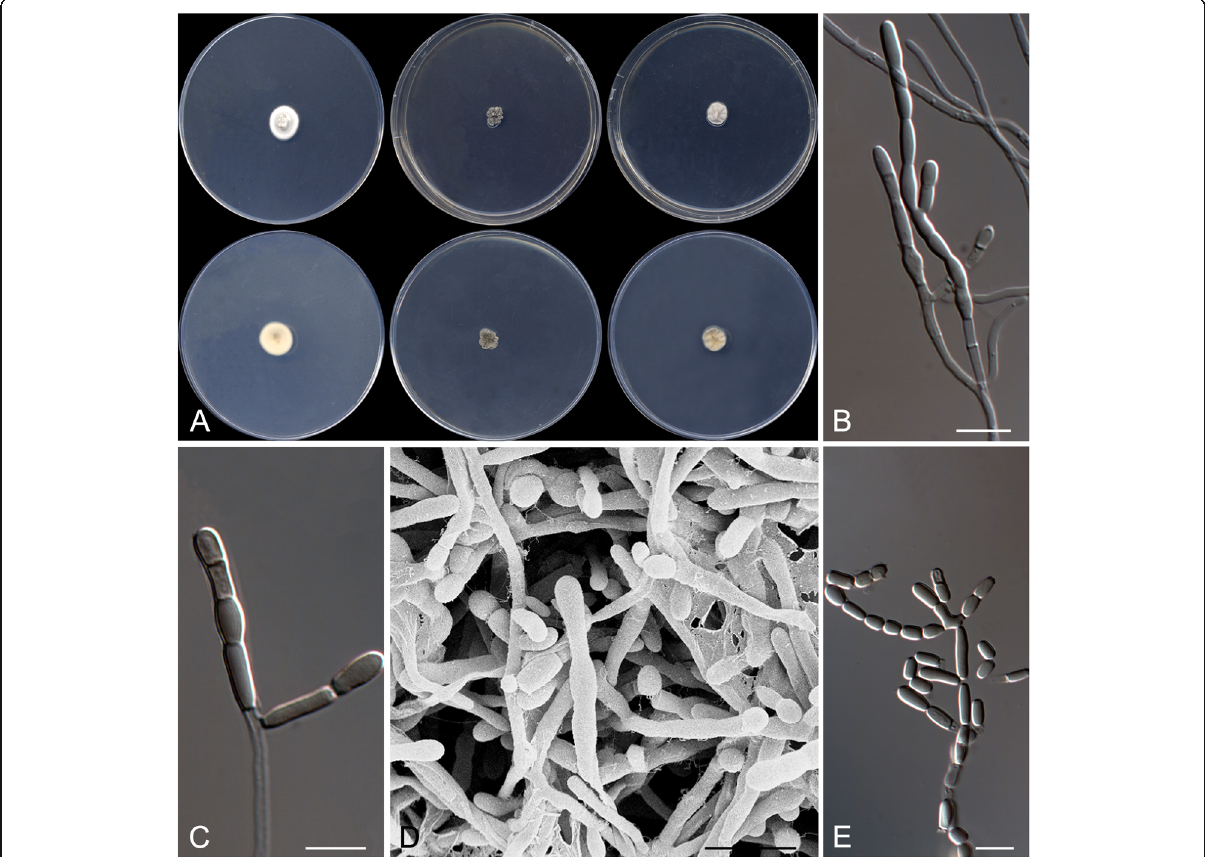
Fig. 10 Oidiodendron mellicola CBS 143839 T . a Colonies on PDA at 15 °C and at 25 °C, and on G18 at 25 °C (left to right), surface and reverse (from top to bottom). b – d Conidiophores. e Disarticulating chains of conidia. Scale bar = 10 μ